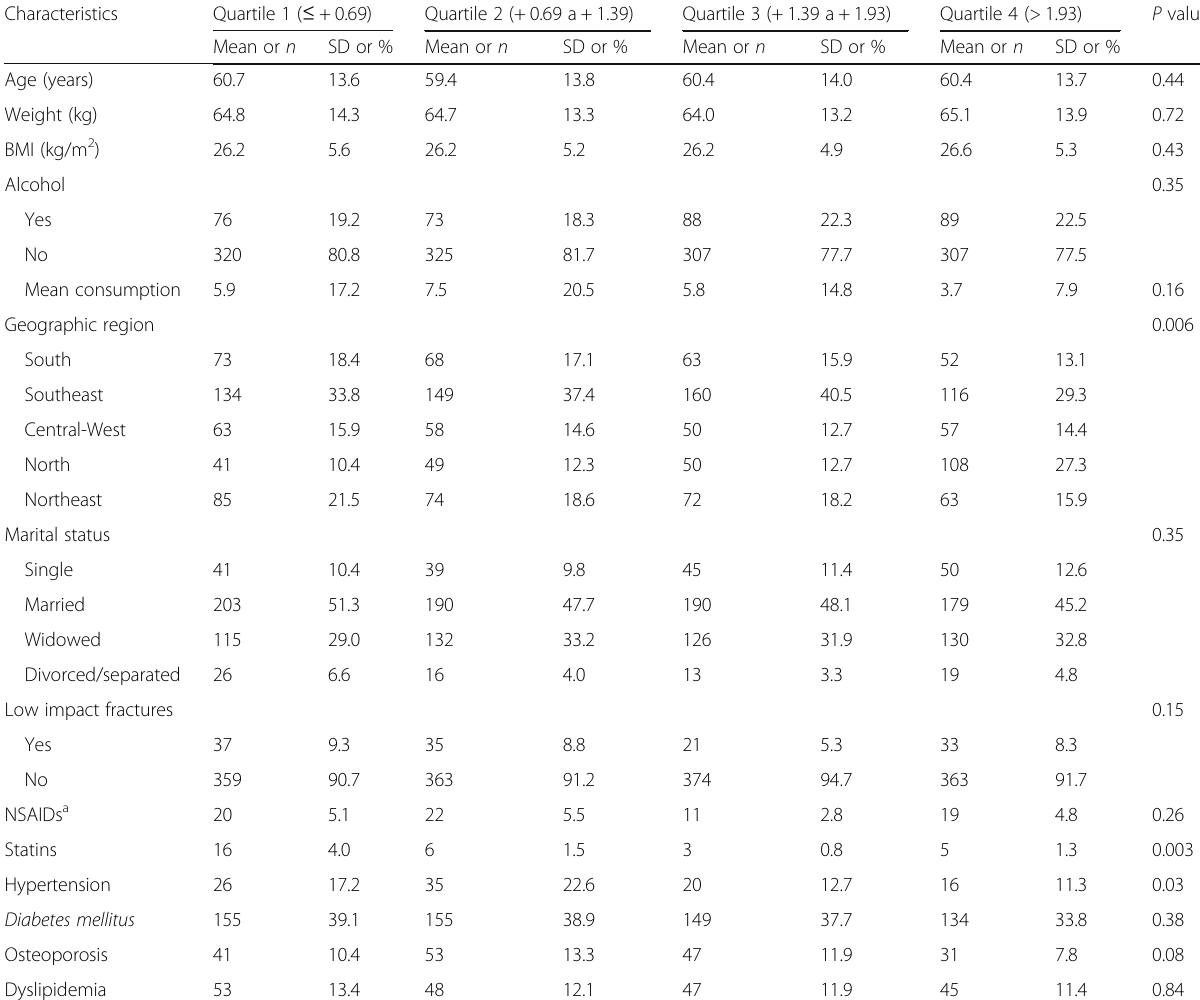
Table 5 Characteristics of the participants according to DII quartile for Brazilian women